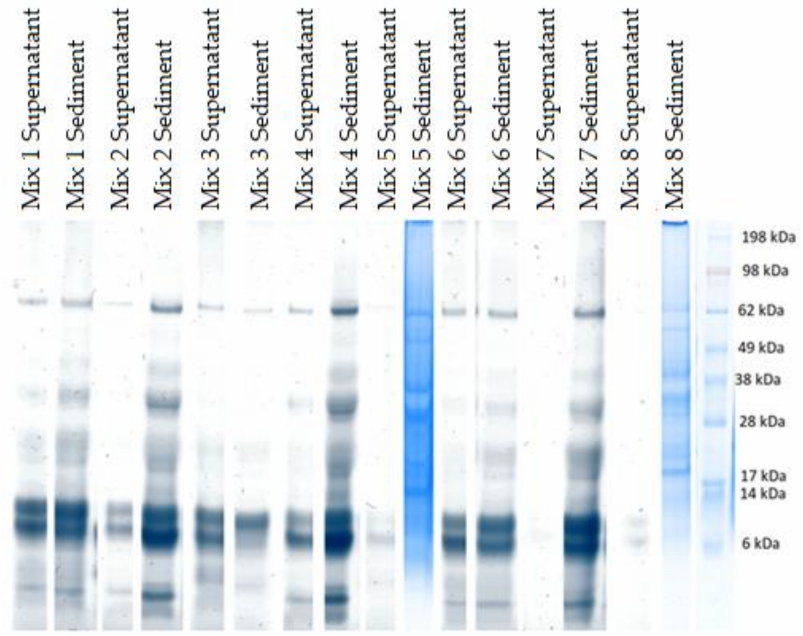
Figure 2. Major protein sizes as determined by SDS-PAGE for the mixed samples. Analyzed under reducing condition. Furthest left lane: MW